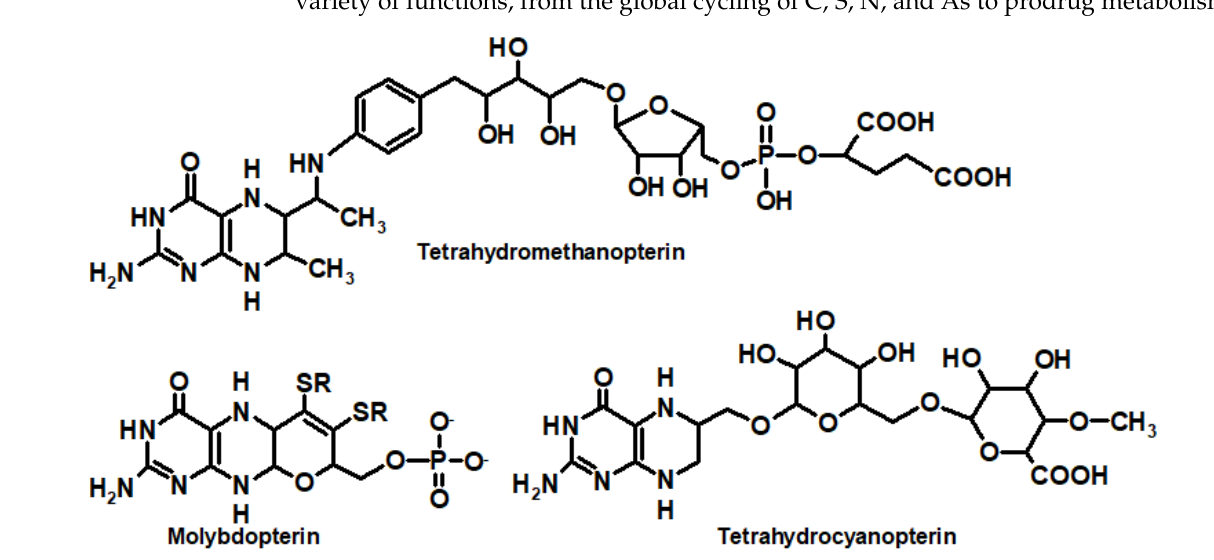
Figure 3. Chemical formulas of unconjugated tetrahydropterin coenzymes.